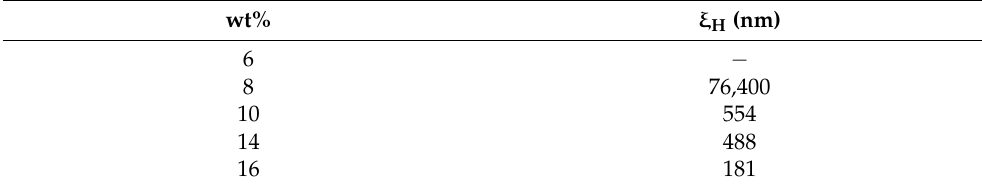
Table 1. Mesh size of PVA solution with different